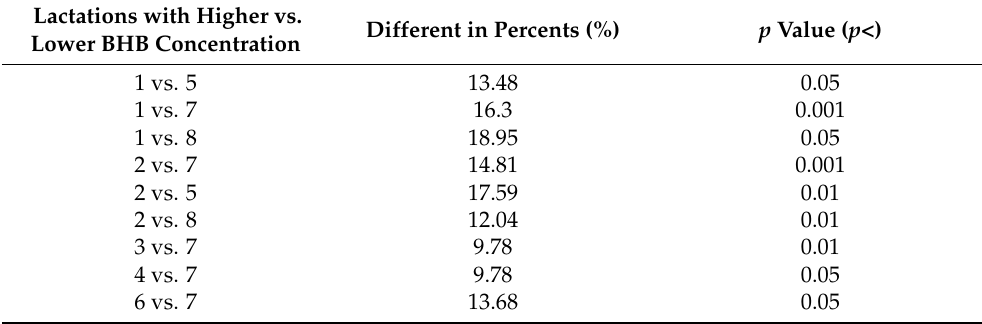
Table 1. Statistically significant differences between lactations with higher and lower BHB concentration. Lactations with Higher vs. Lower BHB Concentration